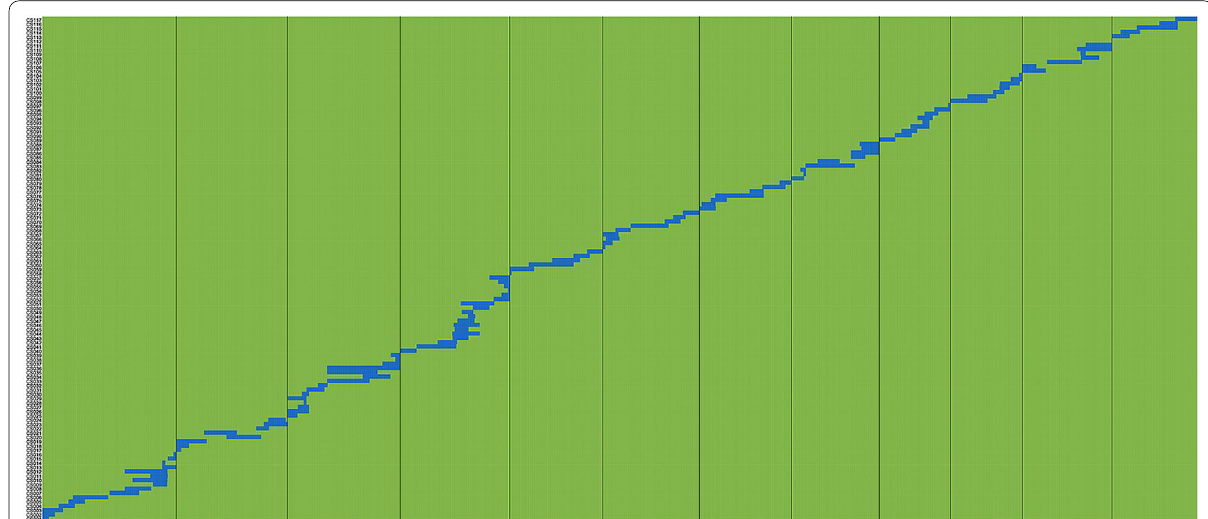
Fig. 2 Bin-physical map of the 117 CSSLs constructed using molecular markers and whole-genome resequencing. Green and blue represent HHZ and BAS, respectively